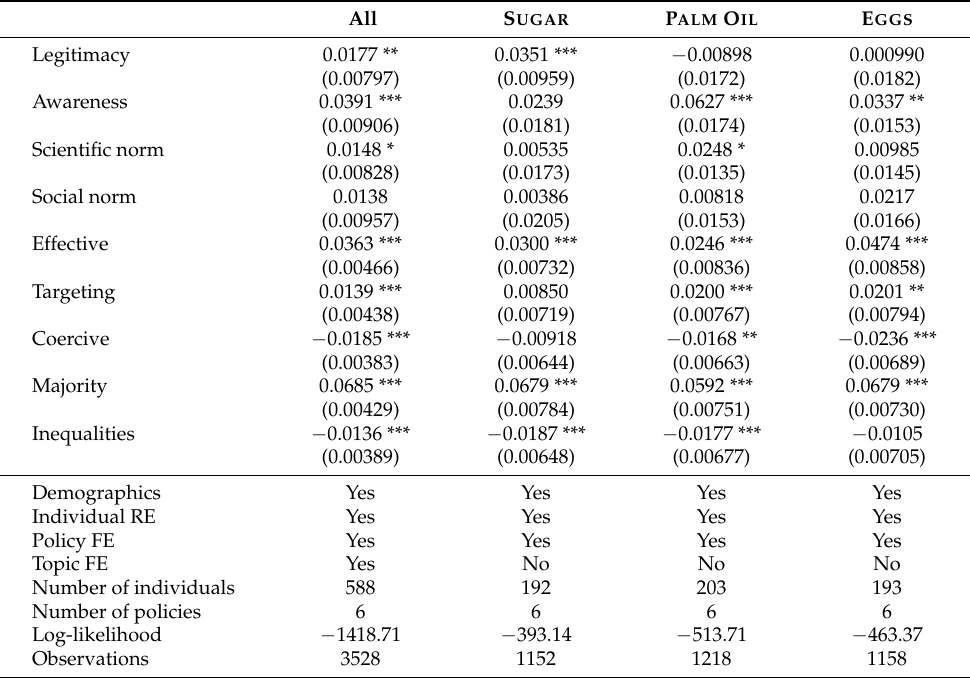
Table A8. Regression of vote —confirmatory